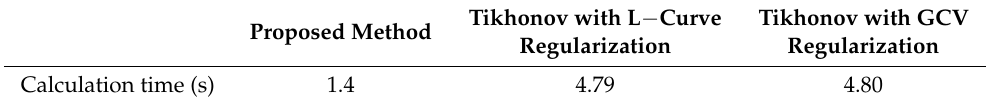
Table 7. Calculation time in Example 3.